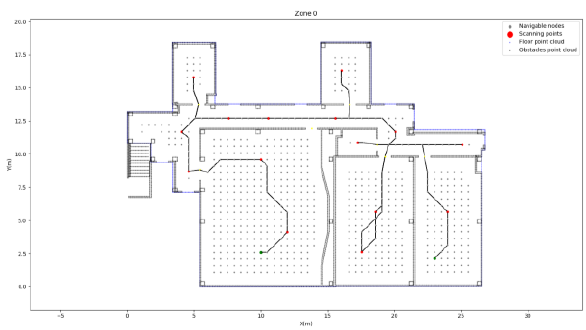
Figure 12. Optimal route for passing once for all scan positions.